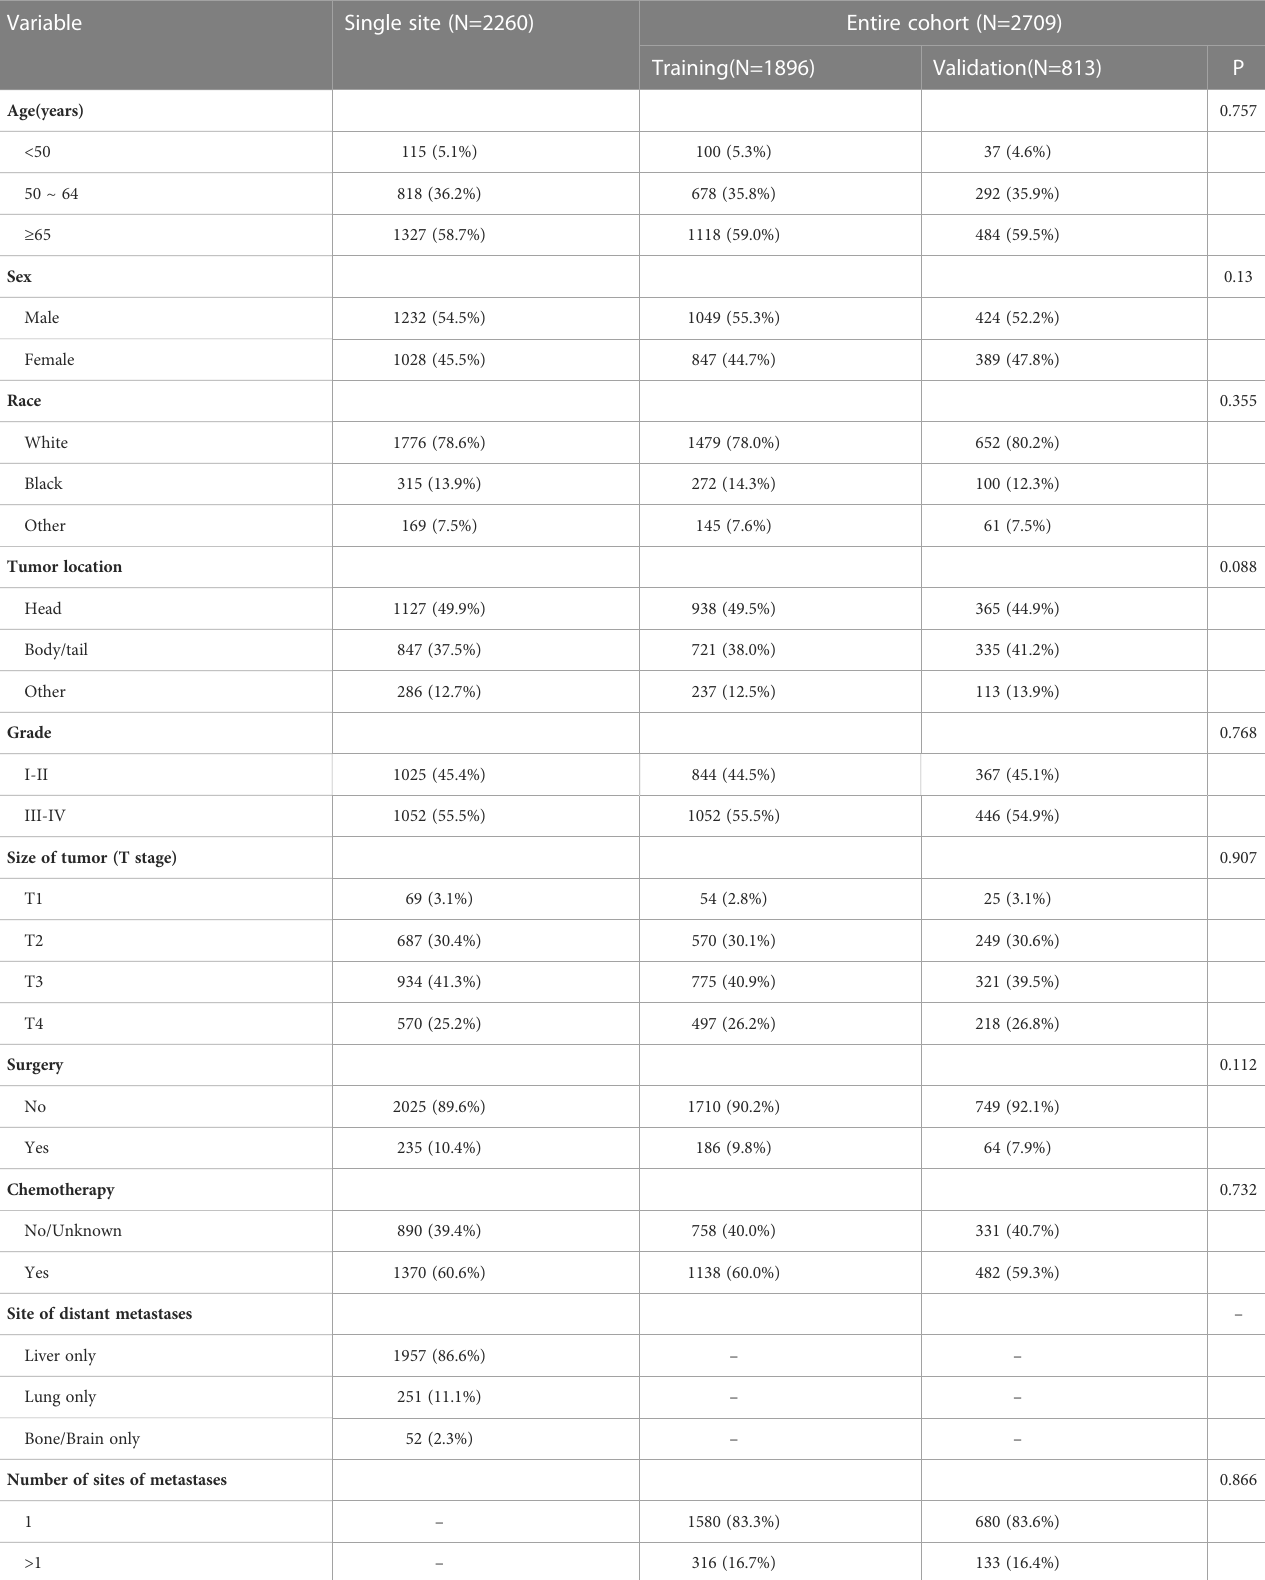
TABLE 1 Baseline clinical characteristics of metastatic PDAC